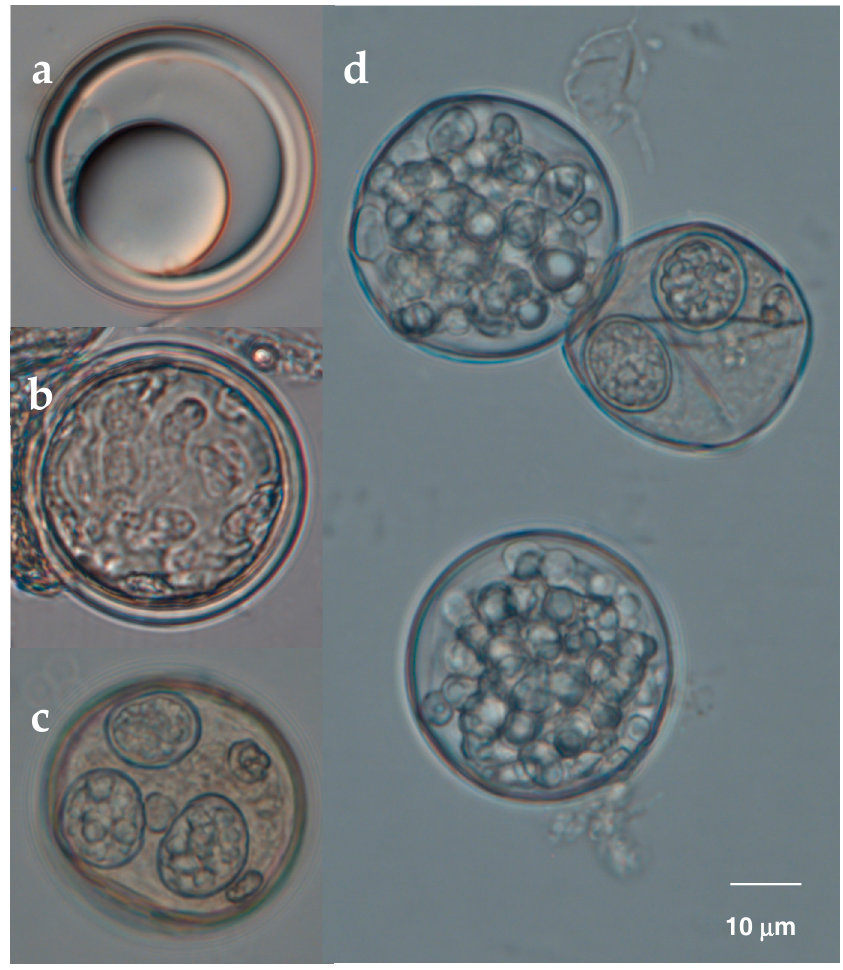
Figure 6. Healthy and mycoparasitized Entomophaga maimaiga resting spores. Parasitism was detected by comparing morphology of healthy spores ( a ) versus caged resting spores used as baits in soil samples from oak forests. Most of the resting spores used as bait were parasitized, misshapen, and filled with different fungal or fungi-like structures ( b – d ) indicating presence of multiple mycoparasitic species. (From [103]).